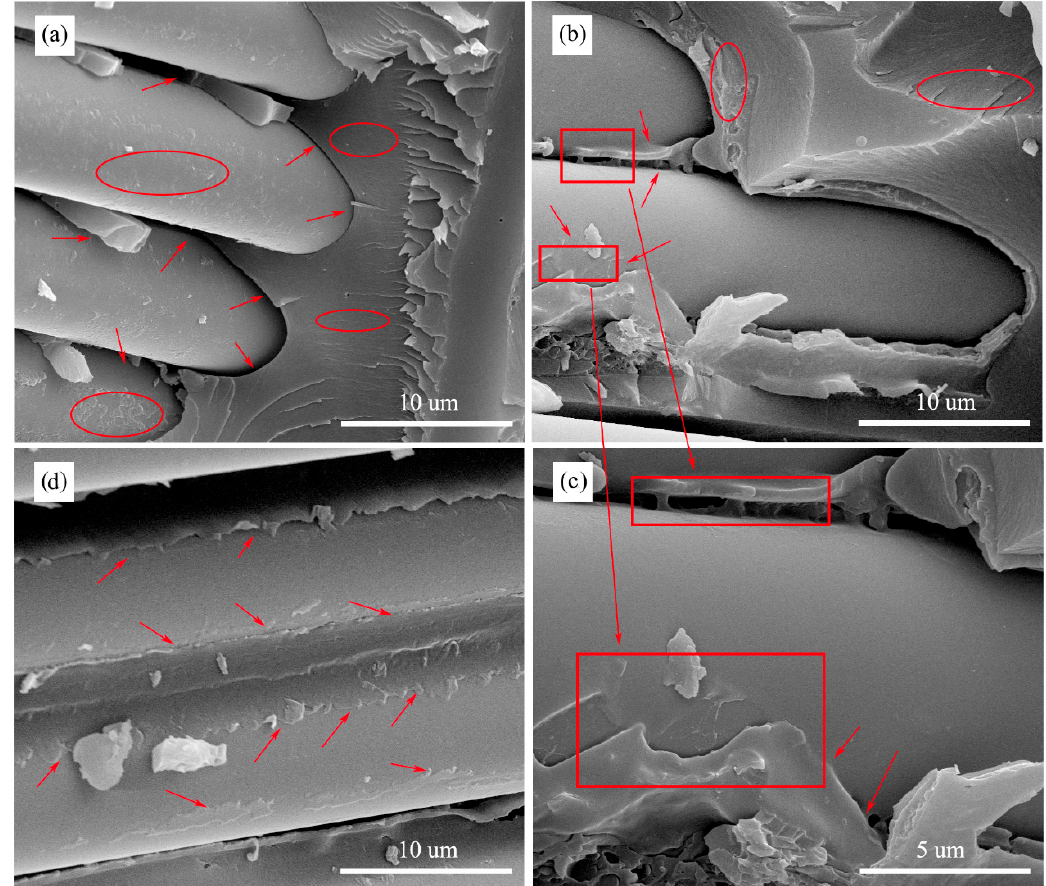
Figure 4. SEM image of the various composite laminates: ( a ) BA-ph; ( b ) BA-ph/PEN blends with 20 wt % PEN content; ( c ) the zoom in image of ( b , d ) BA-ph/PEN blends with 40 wt % PEN content; the arrows reflected the gaps between the matrix and GF in Figure 3a, as well as adhesion properties in Figure 3b–d; the ovals reflected the rough surface of GF and the smooth surface of the matrix; the rectangles marked the zoom in image of the adhesion properties of the composites in a particular area.